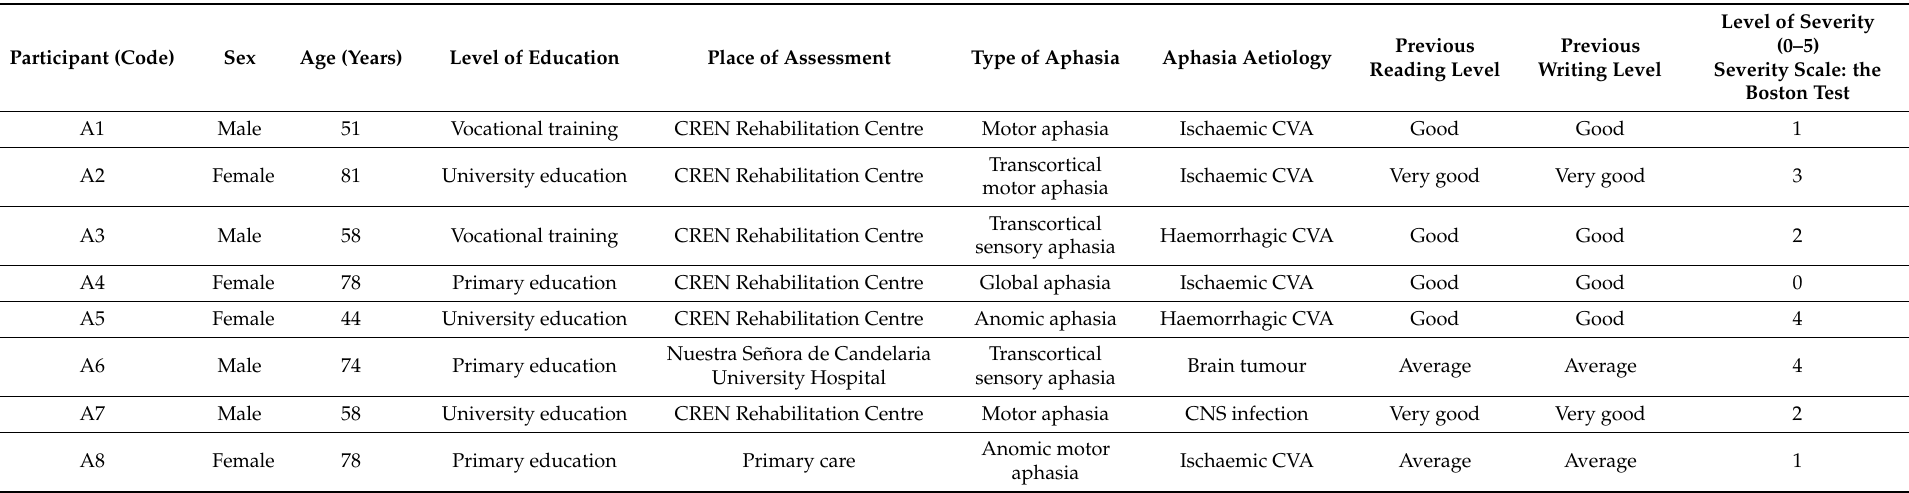
Table 3. Main demographic and clinical characteristics of the participants included in the two phases of the pilot